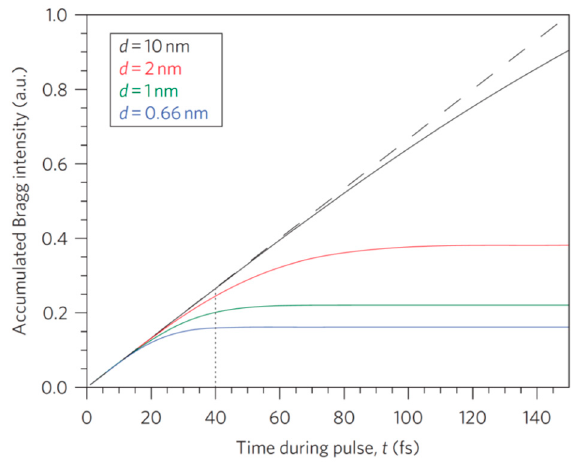
Figure 7. Plot of relative accumulation of Bragg signal for I peak = 1 × 10 17 W cm –2 and a pulse duration ∆ t = 150 fs. Bragg intensities initially accumulate at the same rate proportional to I peak . As expected, disorder affects higher-resolution peaks sooner (alike to the Debye–Waller effect) and termination of Bragg intensity accumulation may occur during the transit of the X-ray pulse through the crystal, leading to apparent pulse lengths ( ∆ t app ) shorter than the duration of the incident pulse. In this case, ∆ t app = 40 fs (black vertical dashed line), which is close to the turn-off time for the highest-resolution peaks at 0.76 nm. Figure adapted from Reference [92] with permission from Springer Nature.